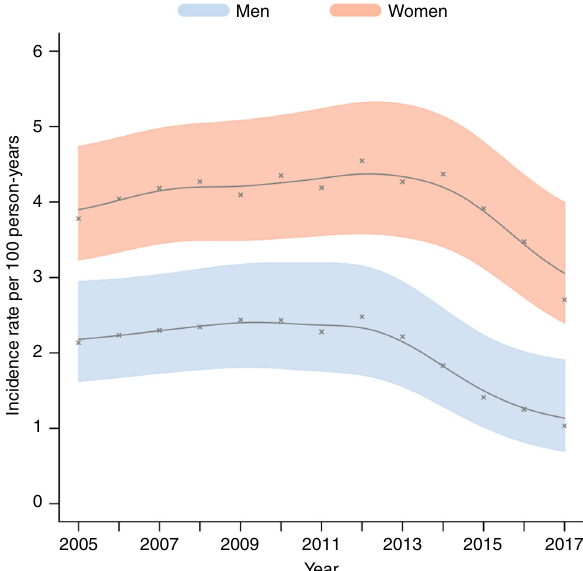
Fig. 1 HIV incidence rates with 95% con fi dence intervals (CIs). The fi gure shows that male and female HIV incidence declined after 2012 and 2014, respectively, with an overall decline of 43% between 2012 and